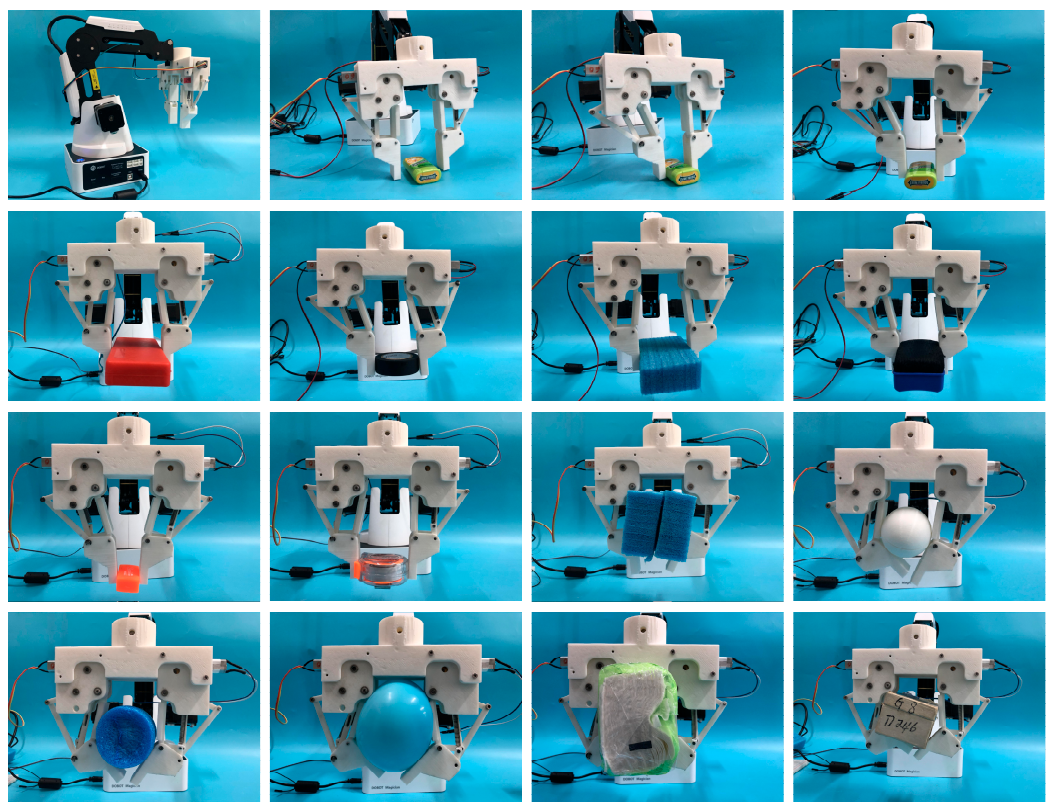
Figure 11. Grasping experiments of the VGS hand. Table 1. Basic parameters and test